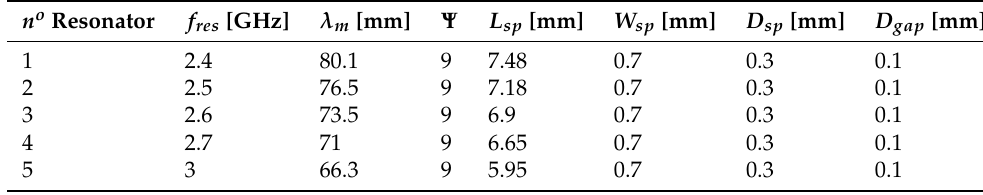
Table 1. Design parameters of the five spiral